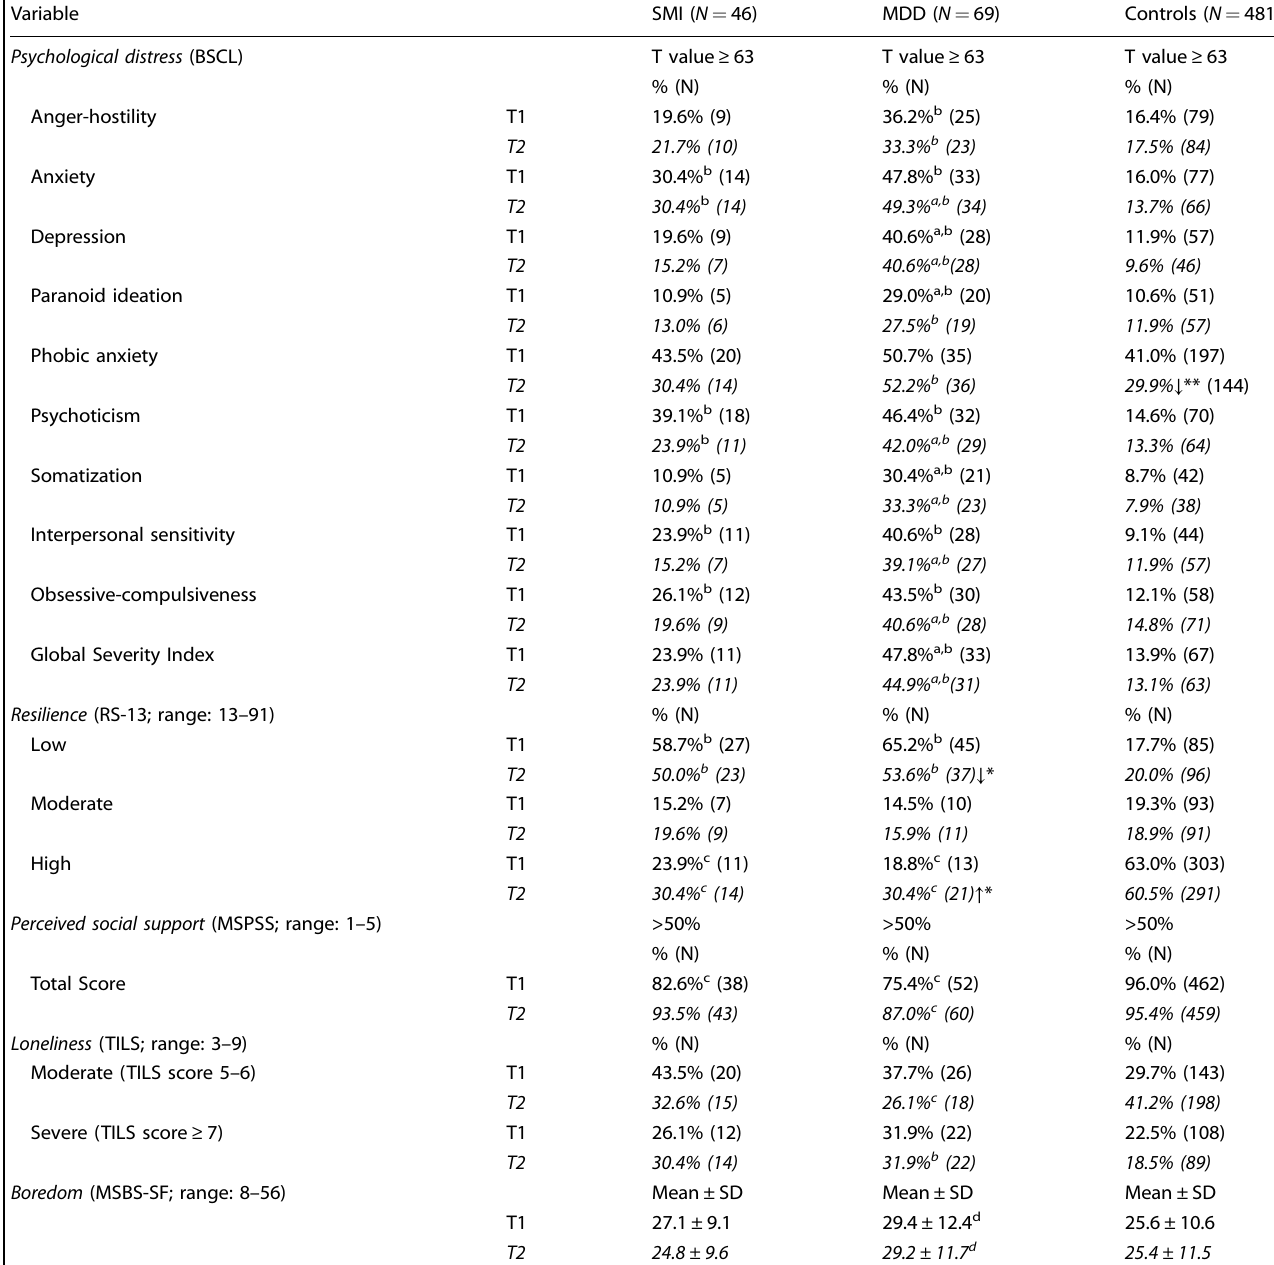
Table 3. Psychological distress, resilience, perceived social support, loneliness, and boredom at baseline (T1) and follow-up